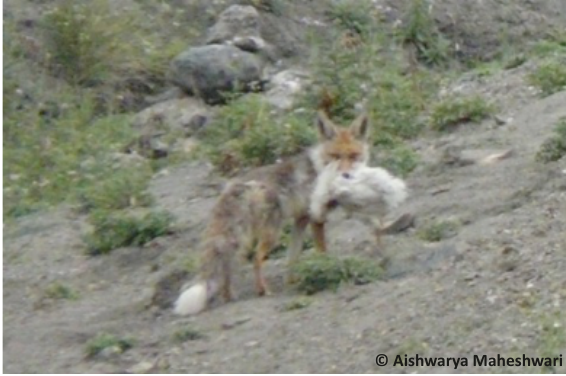
Image 1. Red Fox predation on domestic fowl